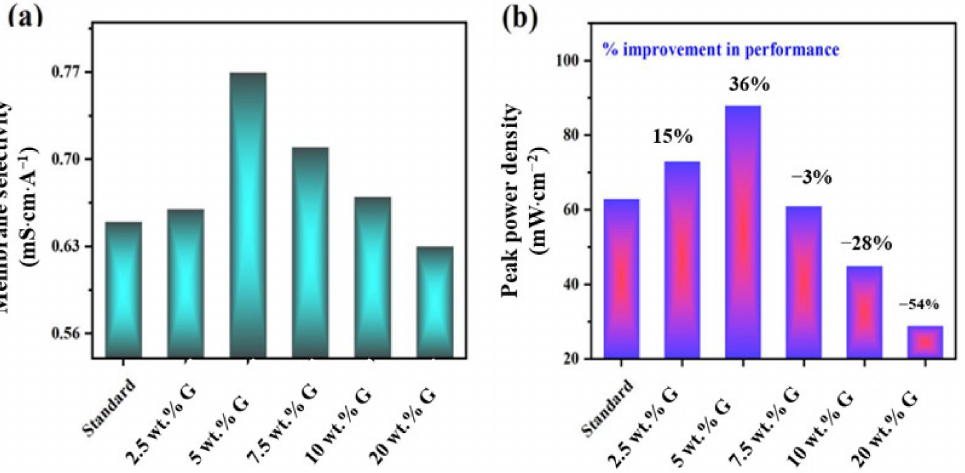
Figure 7. Plot of impact of graphene wt.% on ( a ) membrane selectivity and ( b ) peak power density at 1 M methanol and 60 ◦ C cell